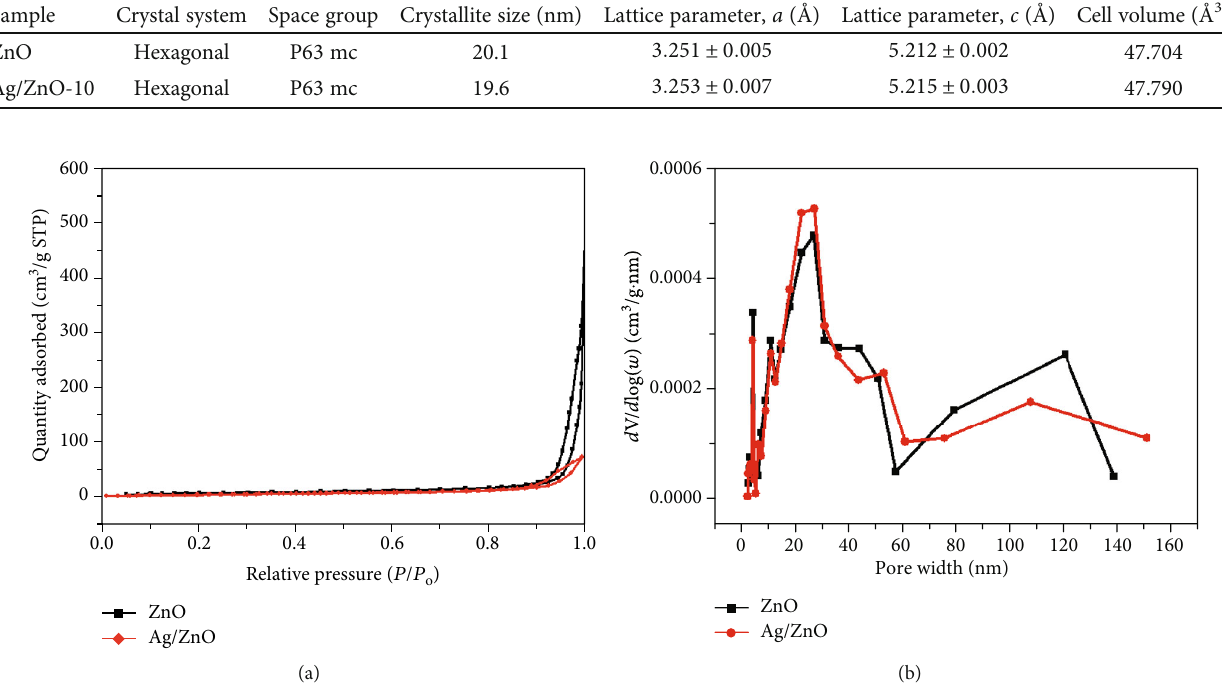
Figure 3: (a) N adsorption/desorption isotherms and (b) pore size distributions of ZnO and Ag/ZnO-10 nanocomposite. 2 Table 2: The textural properties of ZnO and Ag/ZnO-10 composite. Samples